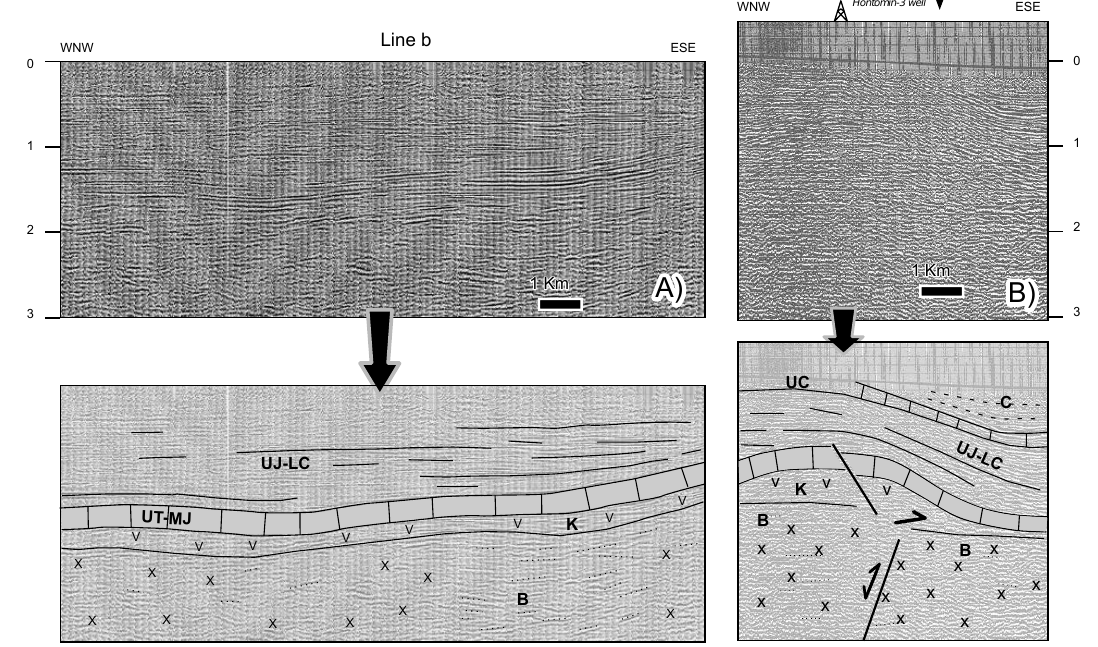
Fig. 9. WNW-ESE striking seismic lines b (A) and c (B) , with corresponding line-drawing.